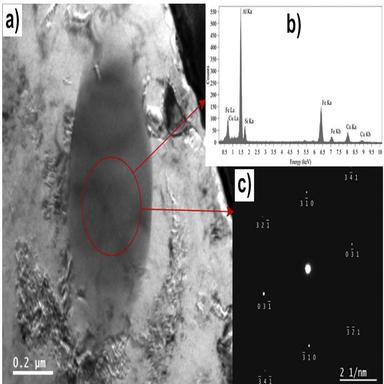
a) Bright field TEM image obtained on a grain that was identified to be a ternary Fe-Al-Si grain. The EDS analysis (b) and the SAED pattern (c) were obtained at the encircled area, and confirmed the presence of Fe4Al17.5Si1.5 phase.